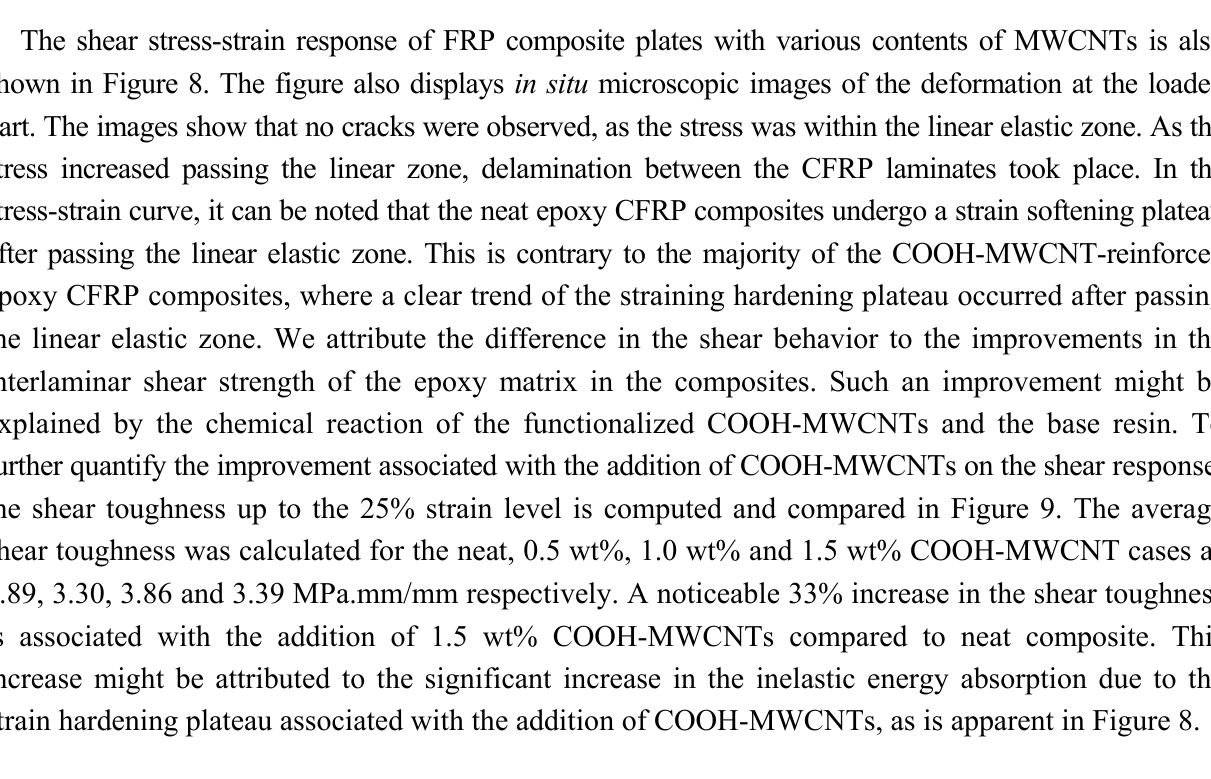
Figure 8. Shear stress-strain curves for composite plates with in situ microscopic